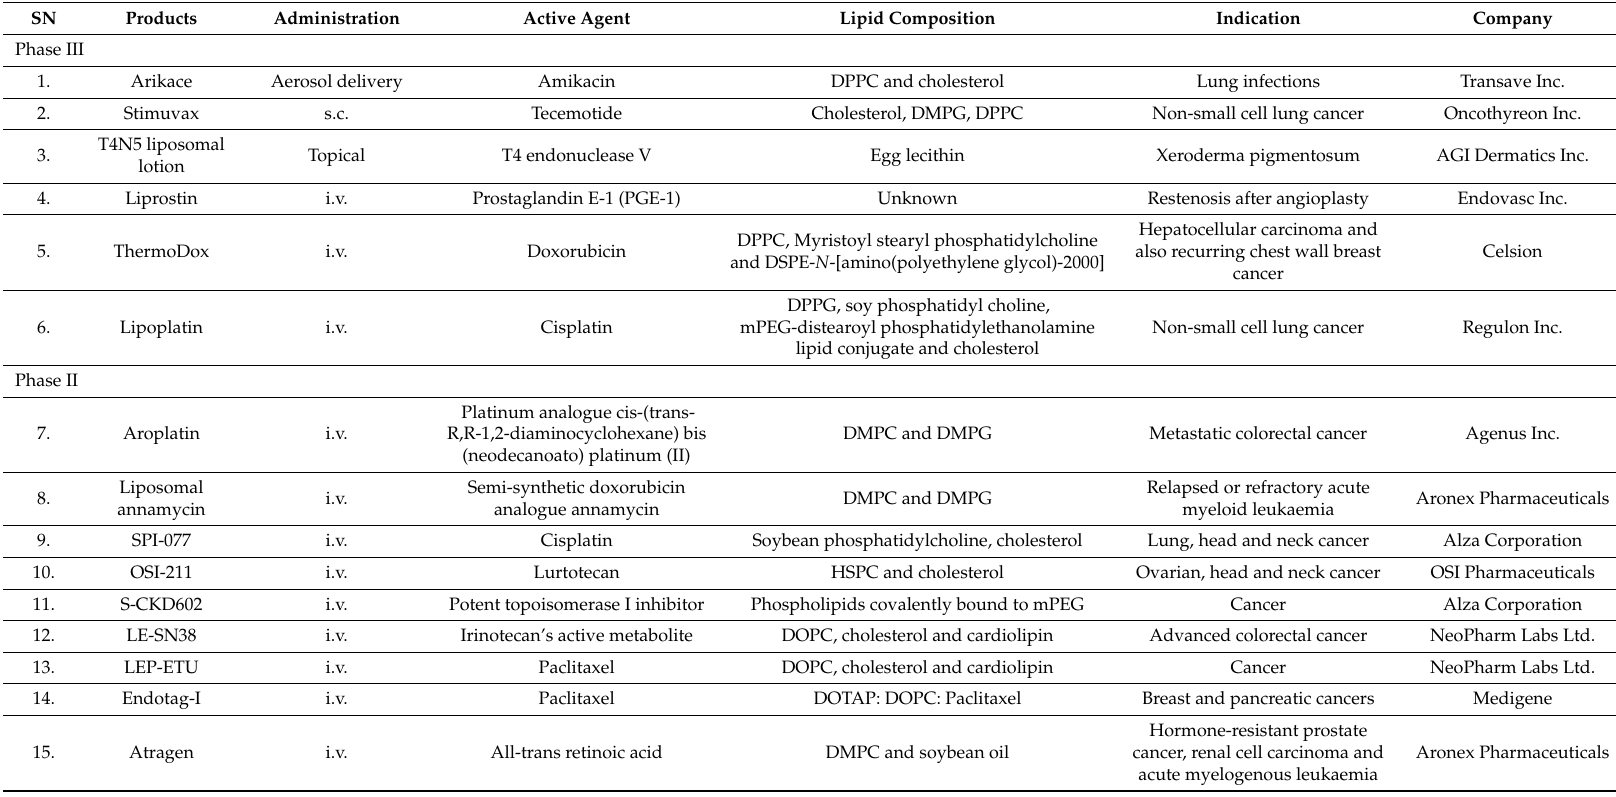
Table 2. Liposomal formulations present in clinical